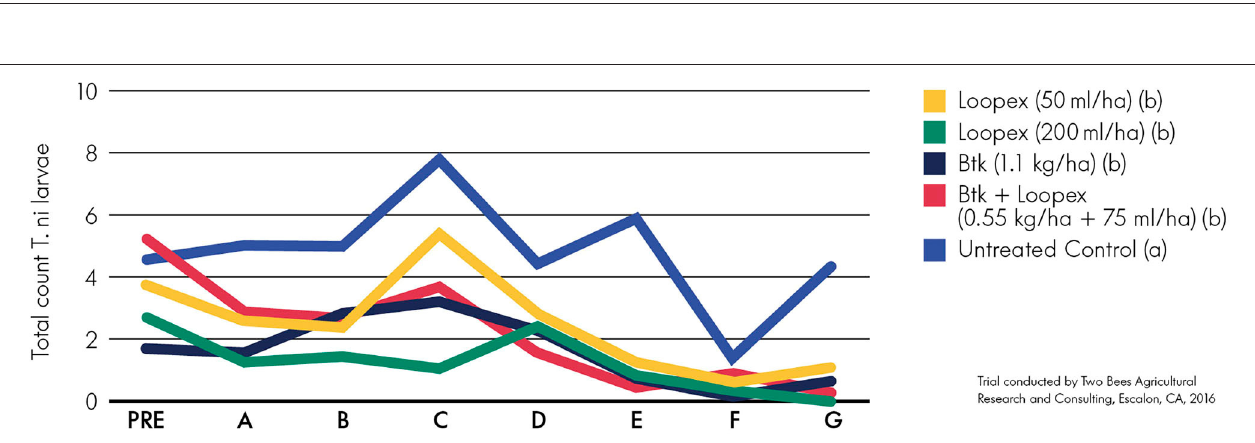
FIGURE 1 | Efficacy (%) based on the mean percentage of damaged tomato fruits of the different treatments. Spexit was used in two different application rates, tankmixed with Bta as well as in rotation with spinosad. Data were analyzed using analysis of variance, followed by the LSD post-hoc test. Significance was determined by p < 0.05 and is shown by letters (a–d).